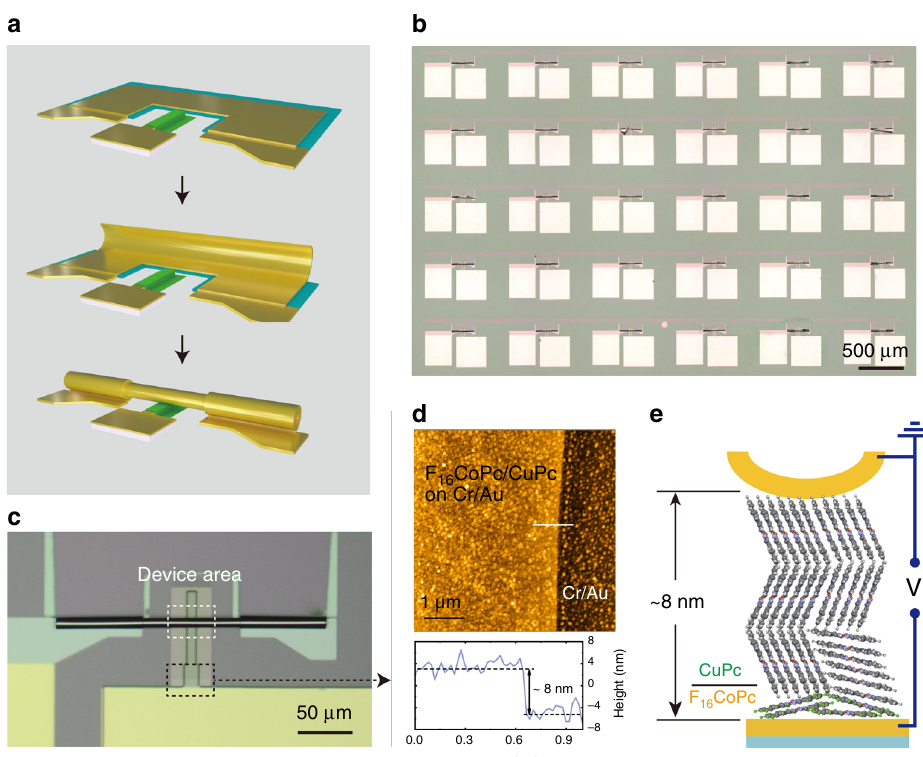
Fig. 3 Con fi guration of the molecular-scale recti fi ers. a Formation of rolled-up tube. b Micrograph of the diode device array. c A typical single device based on rolled-up soft contact. d Tapping mode AFM image of F 16 CoPc (1 nm)/CuPc (7 nm) grown on mesa (as marked in c by the black dotted box) and corresponding height pro fi le of the AFM image. e Conceptual picture of the Au ( fi nger)/F 16 CoPc (1 nm)/CuPc (7 nm)/Au